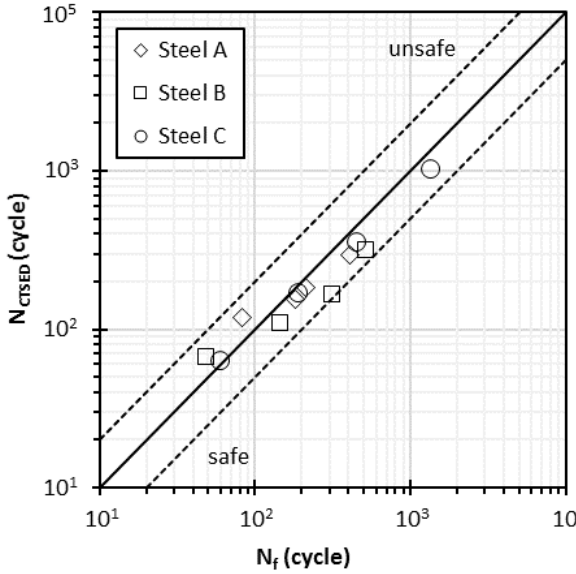
Figure 8. Comparison between numerical and experimental fatigue lives of the proposed model based on the cumulative total strain energy density (N CTSED ).